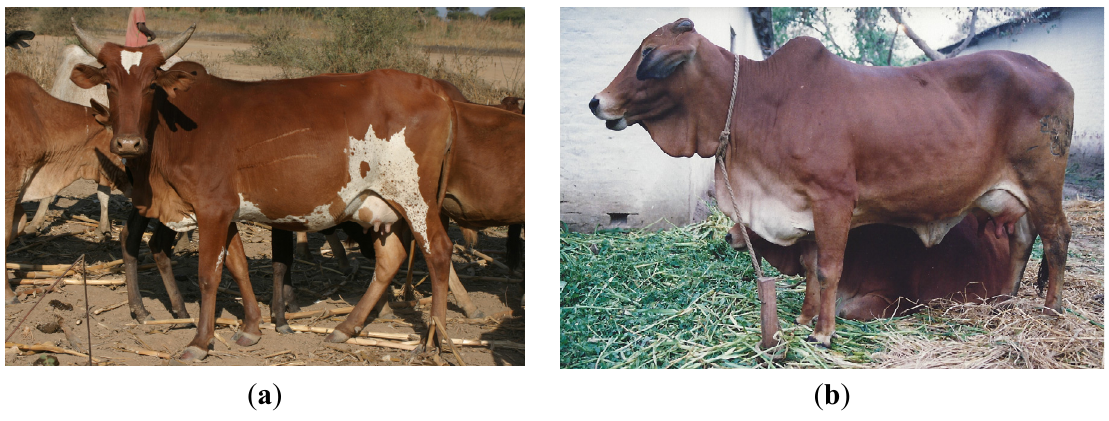
Figure 24. ( a ) Sukuma cow, Tanzania, 2005; ( b ) Sahiwal cow, Pakistan, 1990